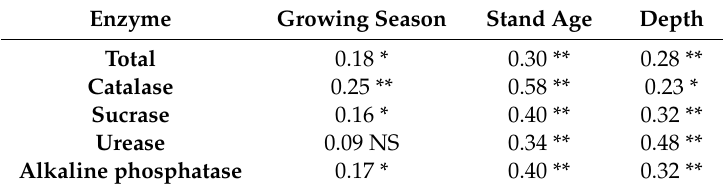
Table 4. The R value from the analysis of similarities (ANOSIM). Enzyme Growing Season Stand Age Depth Total 0.18 * 0.30 ** 0.28